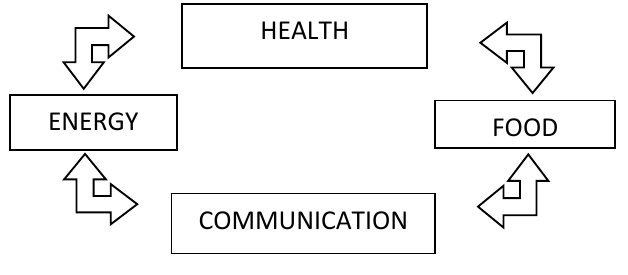
Figure 1: Global Capitalism. Basic